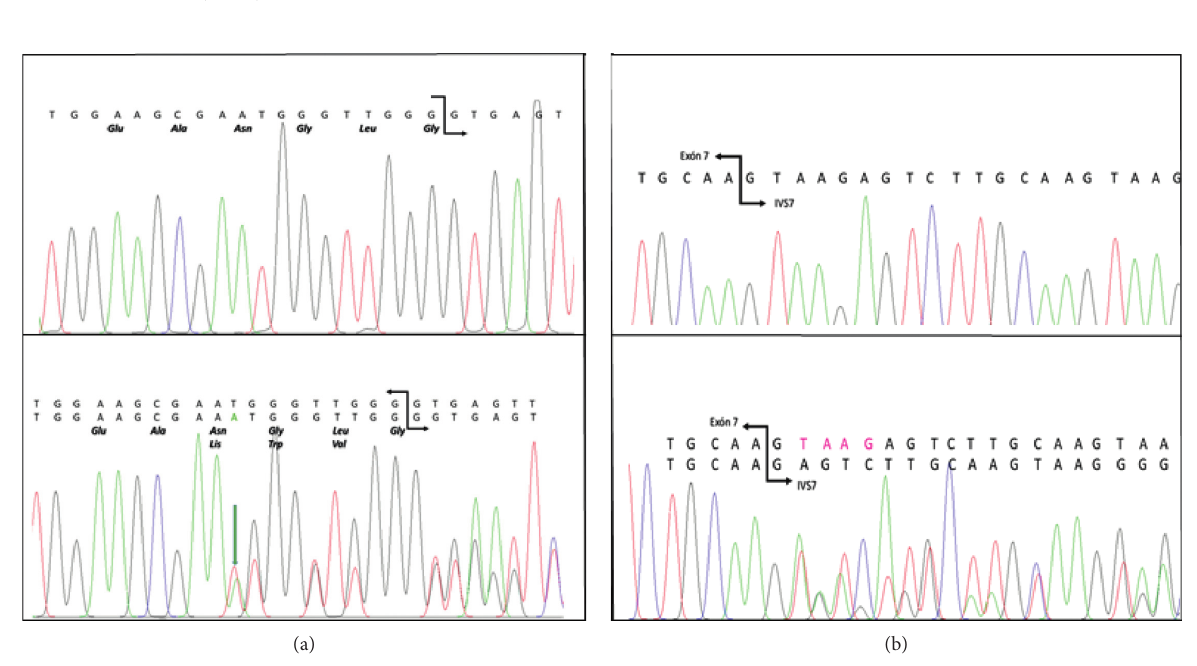
Figure 1: Electropherogram for (a) UROD and (b) HMBS